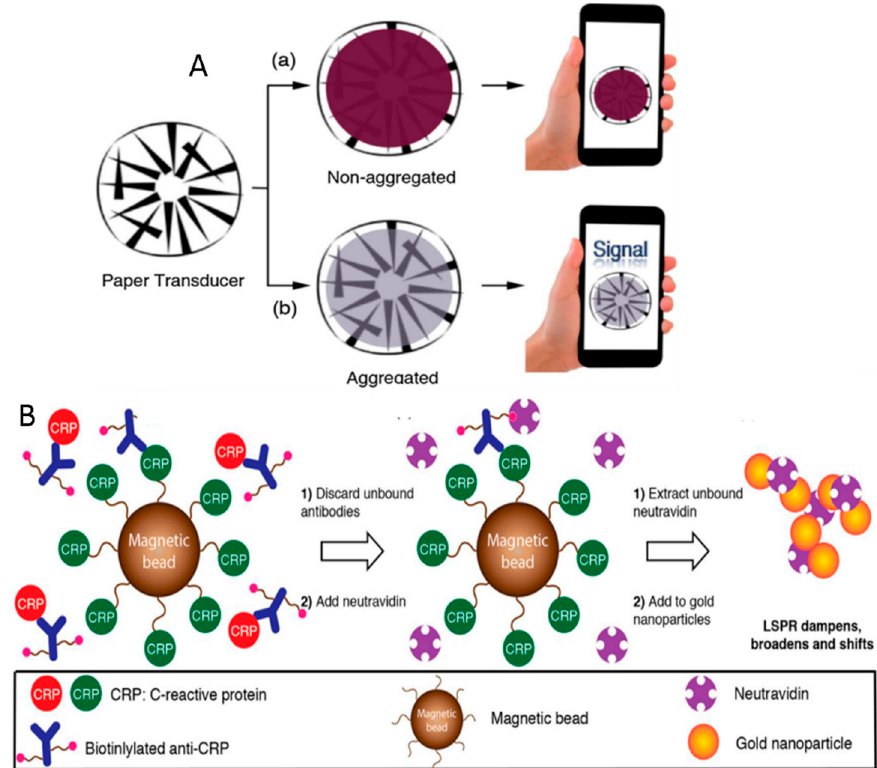
Figure 5. Schematic representation of the paper-based device developed by Russell and de la Rica. Modified from [75]. ( A ) A pattern is printed on filter paper; the presence of non-aggregated gold nanoparticles in suspension block pattern recognition the app, and no signal is generated; while aggregated nanoparticles do not impede pattern recognition ( B ) the methods is based the competitive immunoassay on magnetic beads that can cause the aggregation of gold nanoparticles. Modified with permission from [75].